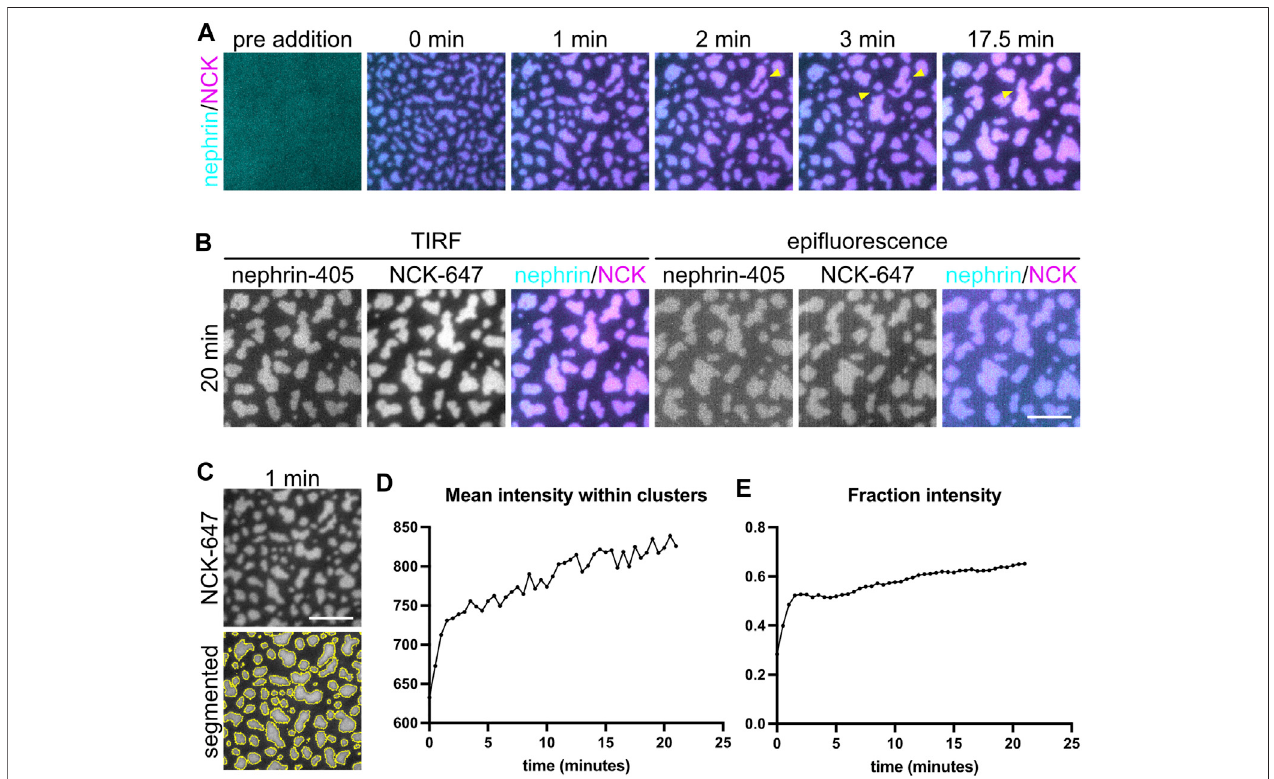
FIGURE 3 | Cluster formation by liquid-liquid phase separation. (A) Time-lapse Total Internal Re fl ection Fluorescence (TIRF) images showing the formation of phase-separated clustersmadeby2 µM Nck(15% labeled byAlexa647), 1 μ M N-WASPwith10 nMHis 8 -nephrin (15%labeledbyAlexa405) onthemembrane.Yellow arrowheads indicate example fusion events. (B) Comparison of TIRF and epi fl uorescence imaging for the clusters described in (A) . (C) Example time point at 1 min of cluster formation in NCK-647 channel (top) and the same image with the outline of the area above threshold for quanti fi cation (bottom). Scale bars, 5 µm. TIRF penetration depth is 110 nm for all channels. (D – E) Quanti fi cation of mean intensity within clusters (D) and fraction intensity of the clusters (E) over the period of time- lapse acquisition.